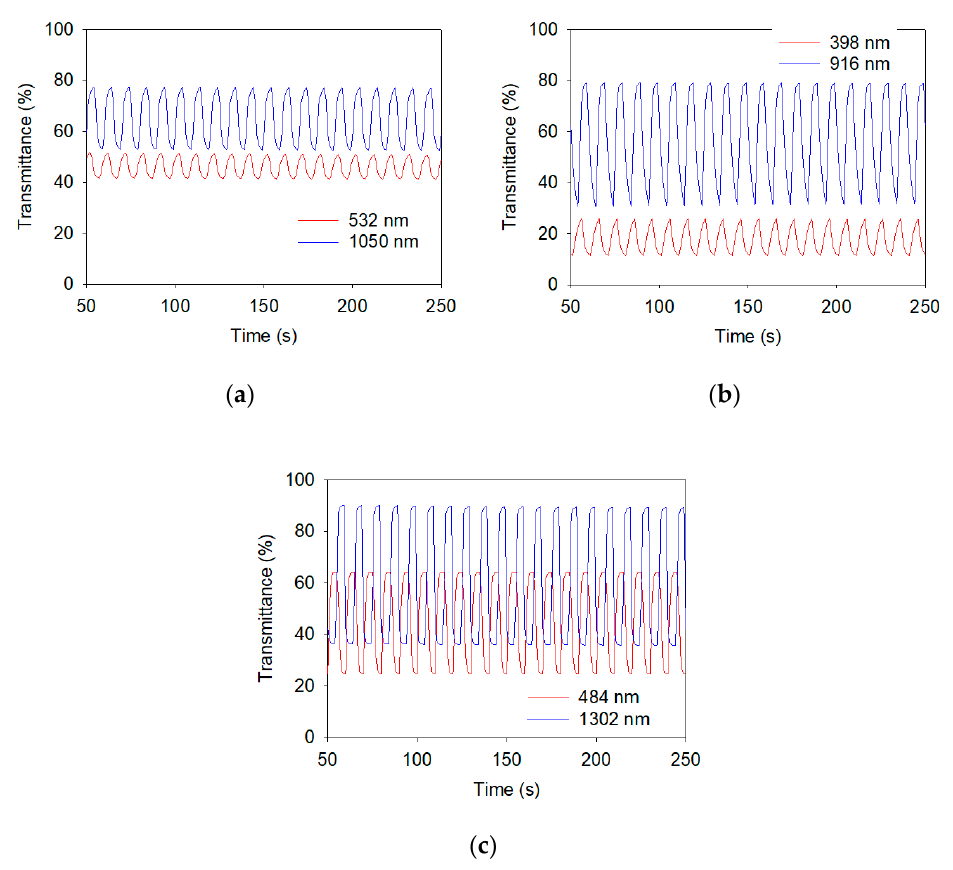
Figure 7. Transmittance profiles of: ( a ) PTTPP film at 532 and 1050 nm; ( b ) P(TTPP ‐ co ‐ DTC) film at 398 and 916 nm; and ( c ) P(TTPP ‐ co ‐ DTP) film at 484 and 1302 nm under potentials between 0 and +1.0 V. Time interval: 5 s. Table 2. Comparisons of the ∆ T max and η max for polymers and